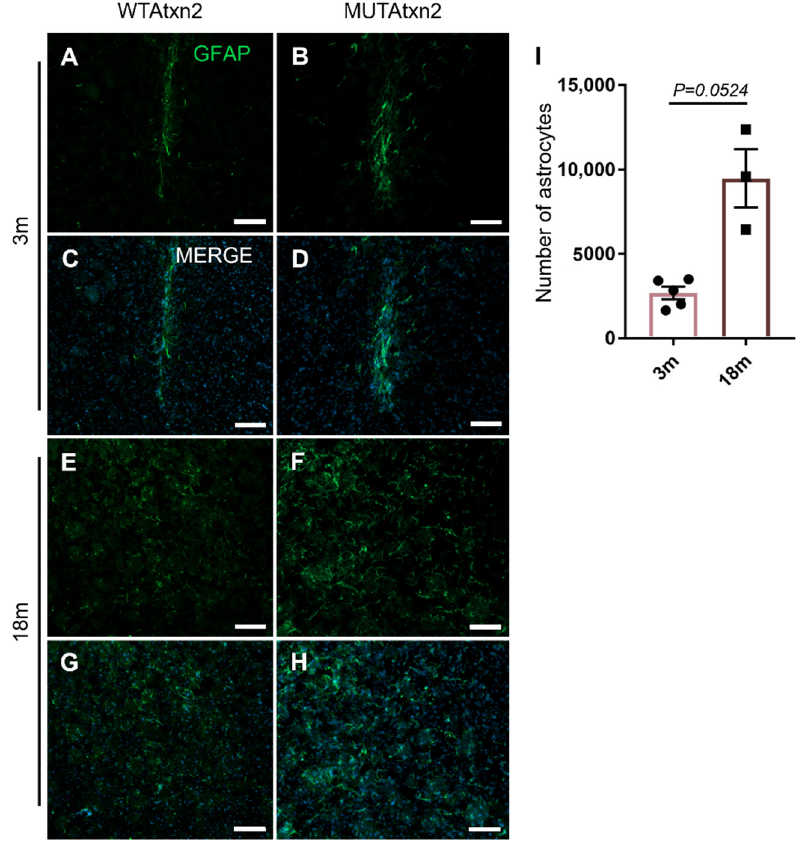
Figure 4. Aged animals displayed a significantly higher number of activated astrocytes. ( A – H ) Aged animals displayed a significantly higher number of activated Representative immunohistochemistry of striatal sections stained with GFAP. Green: astrocytes; blue: DAPI. Scale bar: 500 µm. ( I ) Quantitative analysis of the number of astrocytes in the 3m ( n = 5) and 18m ( n = 3) animal groups. Values are expressed ± SEM (standard error of the mean) (un- paired t -test with Welch’s correction).